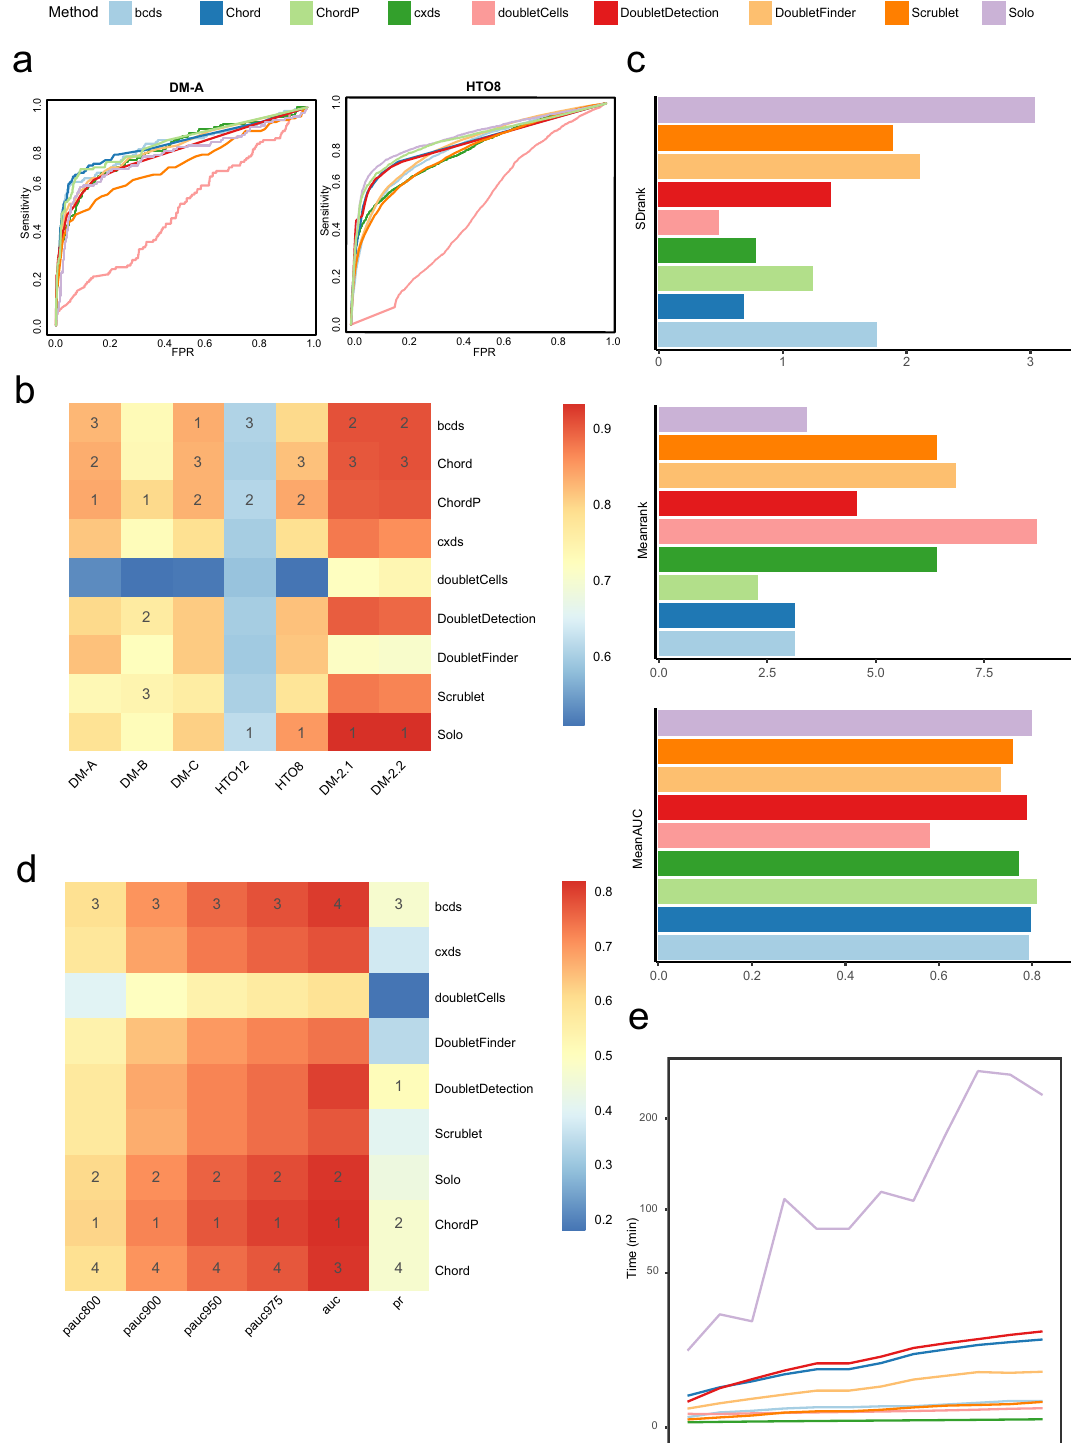
the application of Chord in real-world data and whether the effect